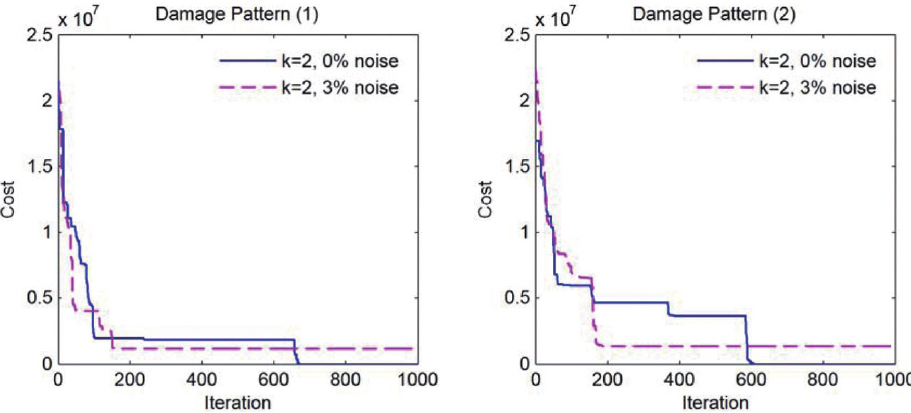
Fig. 9. Convergence curves for two damage patterns of the plane steel truss.